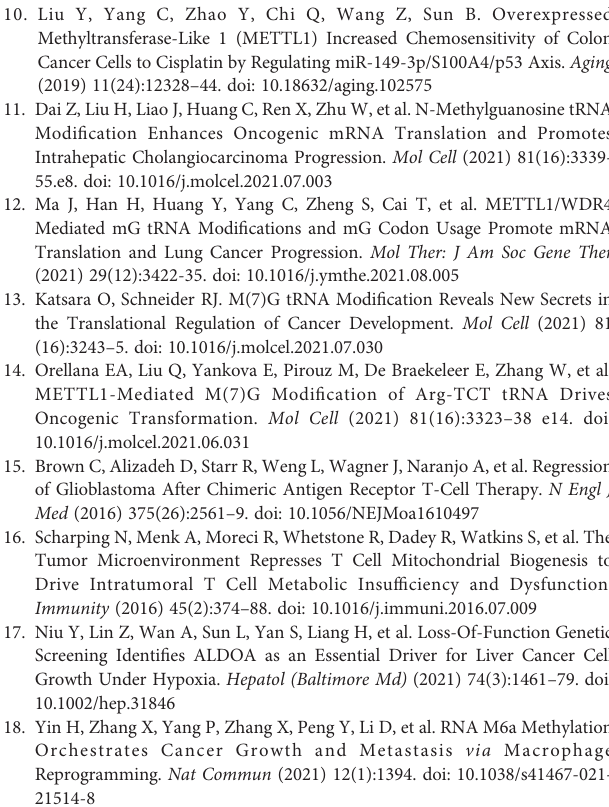
molecules (C) respectively. Supplementary Figure S8 | Role of METTL1 expression in response to ICB therapy. (A) The proportion of patients with immune cell in fi ltration phenotype in low orhigh METTL1 expression groups. (B) Thecolumn chart showedthe proportion of patients without platinum therapy with low or high METTL1 expression who responded to PD-L1 block immunotherapy. (C) Kaplan-Meier curve showed the survival of the high and low METTL1 expression patient without platinum therapy groups in anti-PD-L1 immunotherapy cohort. (D, E) Differences of METTL1 expression between patients with different immunotherapy responses in the GSE78220 and GSE67501 cohorts respectively. (F, G) Differences of METTL1 activity between patients with different immunotherapy responses in the GSE78220 and GSE67501 cohorts respectively. Supplementary Figure S9 | GSEA results based on Hallmark dataset among